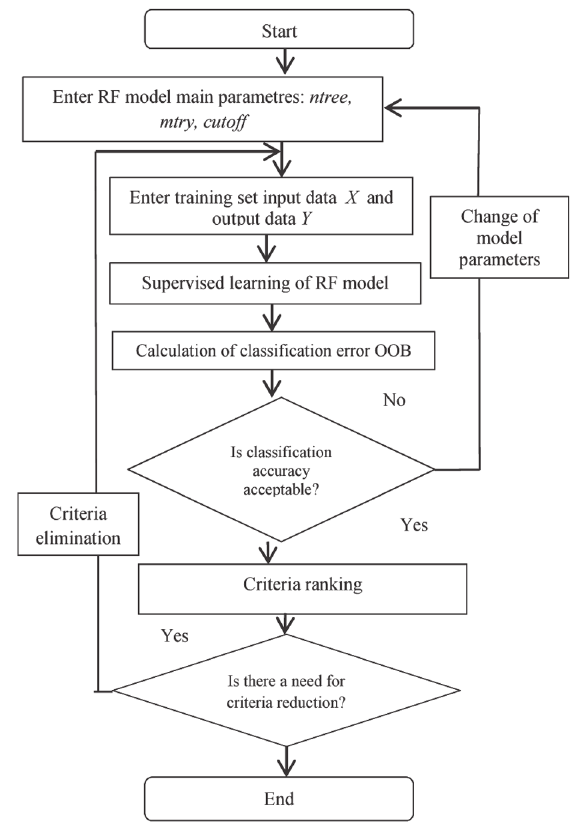
Fig. 4. OOB error